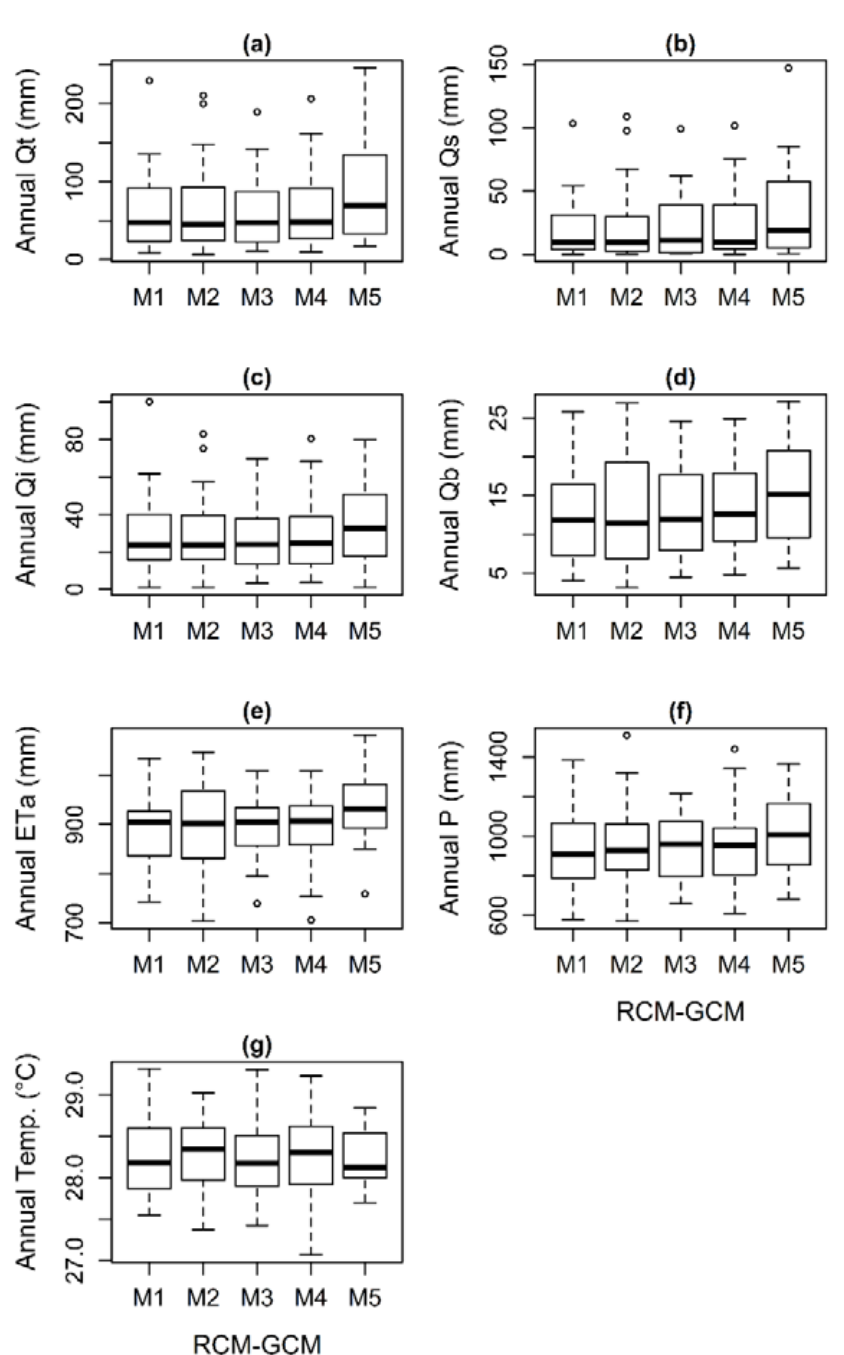
Figure 7. Annual water balance distribution during the reference period (1971–2000) for the five RCM–GCMs using LULC 2013: M1 : CCLM-CNRM; M2 : CCLM-EARTH; M3 : CCLM-ESM; M4 : HIR-